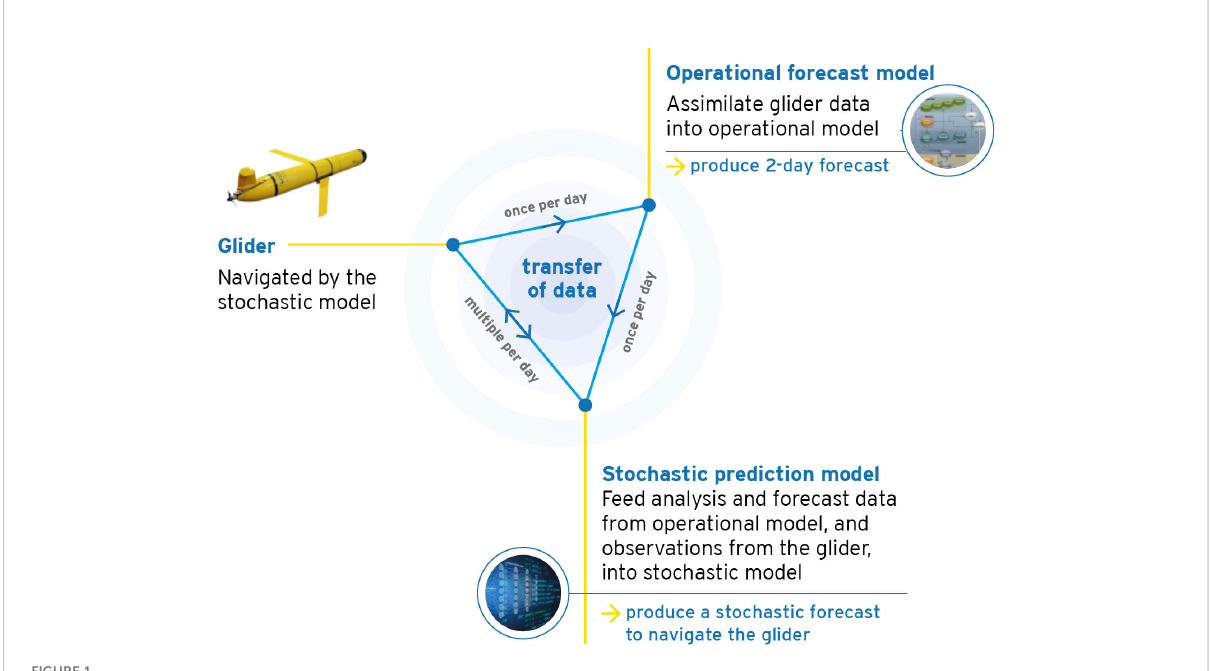
FIGURE 1 Schematic showing the integrated observing and forecasting